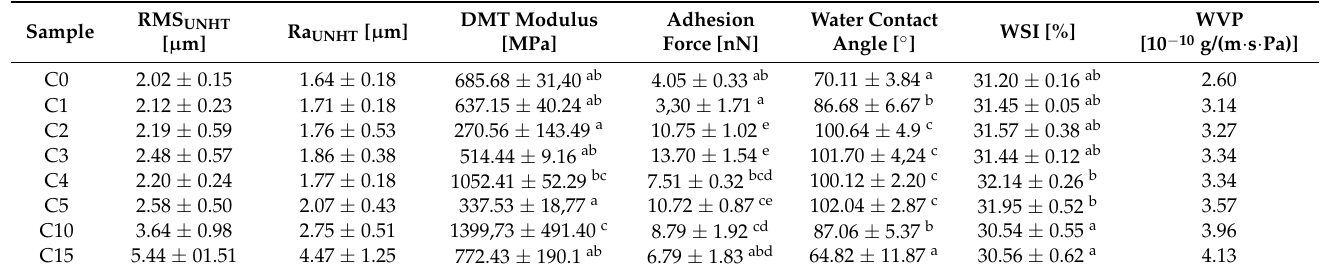
Table 2. Surface and barrier